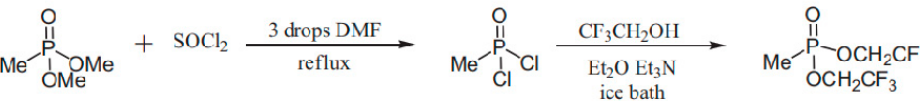
Figure 12. The synthetic route of bis(2, 2, 2-trifluoroethyl) methylphosphonate (TFMP). Adopted from Ref. [209].